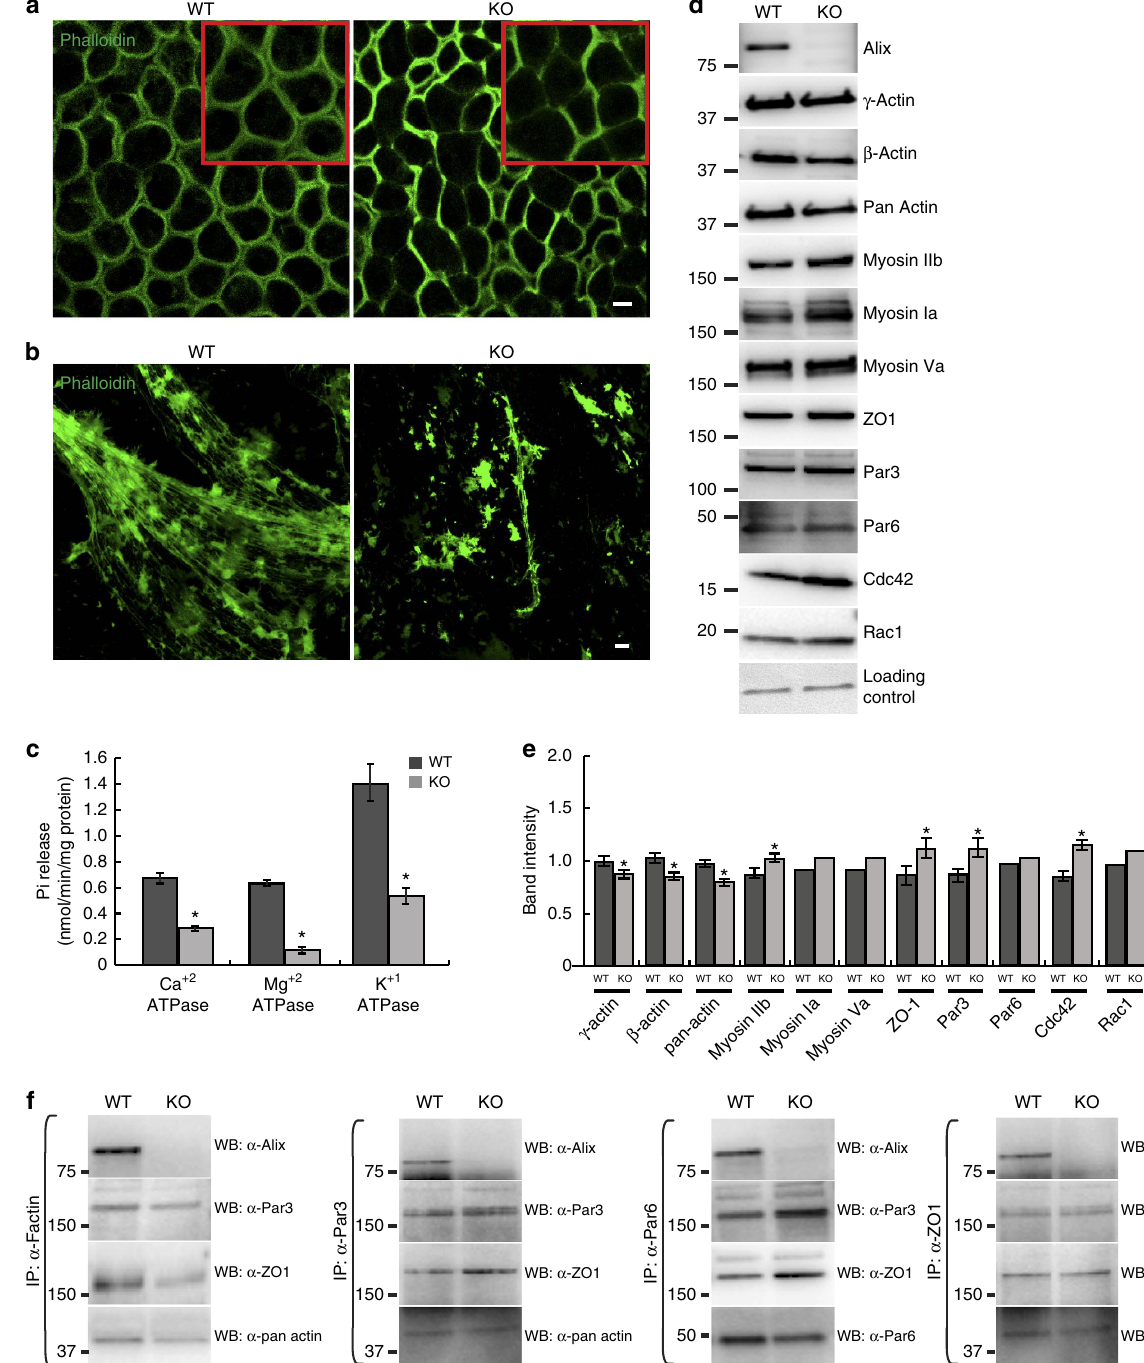
00.21.6 WT KO 0.40.60.81.01.21.4 Figure 6 | Alix maintains the integrity of actomyosin and segregates with actomyosin together with tight junction proteins. ( a ) Confocal images of whole-mount WT and Alix (cid:2) / (cid:2) CP immunostained with phalloidin. Scale bar, 100 m m. ( b ) Purified actomyosin from WT and Alix (cid:2) / (cid:2) brains immunostained with phalloidin. Scale bar, 10 m m. ( c ) Brain actomyosin ATPase activities, measured in the presence of Ca 2 þ , Mg 2 þ and K þ . Data are the mean ± s.d. of three different actomyosin preparations. ( d ) Purified actomyosin from WTand Alix (cid:2) / (cid:2) brains analysed by western blots for the presence of Alix and main components of actomyosin, as well as cell junctions and polarity markers. ( e ) Western blot quantification of actomyosin components. Data shown represent the mean ± s.d. of three independent experiments. * P o 0.05 by Student’s t -test. ( f ) Immunoprecipitations followed by immunoblottings of subcellular fractions (P2) from WT and Alix (cid:2) / (cid:2) brains. Discussion organization in the Alix (cid:2) / (cid:2) CP epithelium and in the Alix In polarized epithelial cells, the crosstalk between the silenced CP cells define a novel role of Alix in maintaining the actin-containing-filament cytoskeleton, forming the actomyosin proper connections between the actin cytoskeleton and the TJ network, and the TJ complexes, specified by ZO-1 and its proteins at the apical side of the epithelial cell membrane. NATURE COMMUNICATIONS|7:11876|DOI: